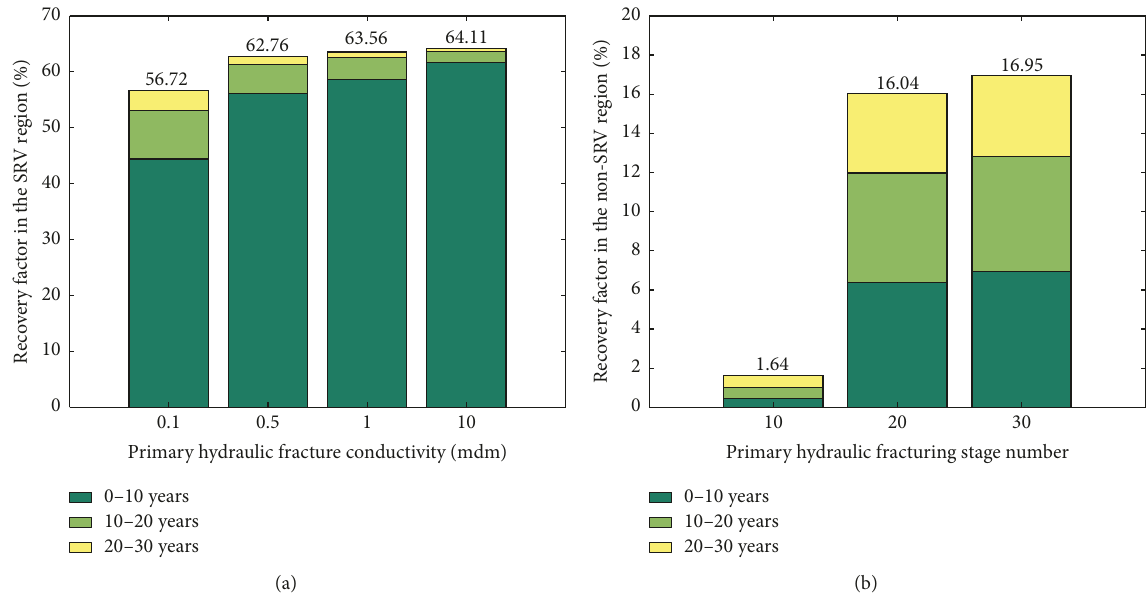
Figure 11: The effect of primary hydraulic fracturing stage number on the recovery factor: (a) SRV region; (b) non-SRV